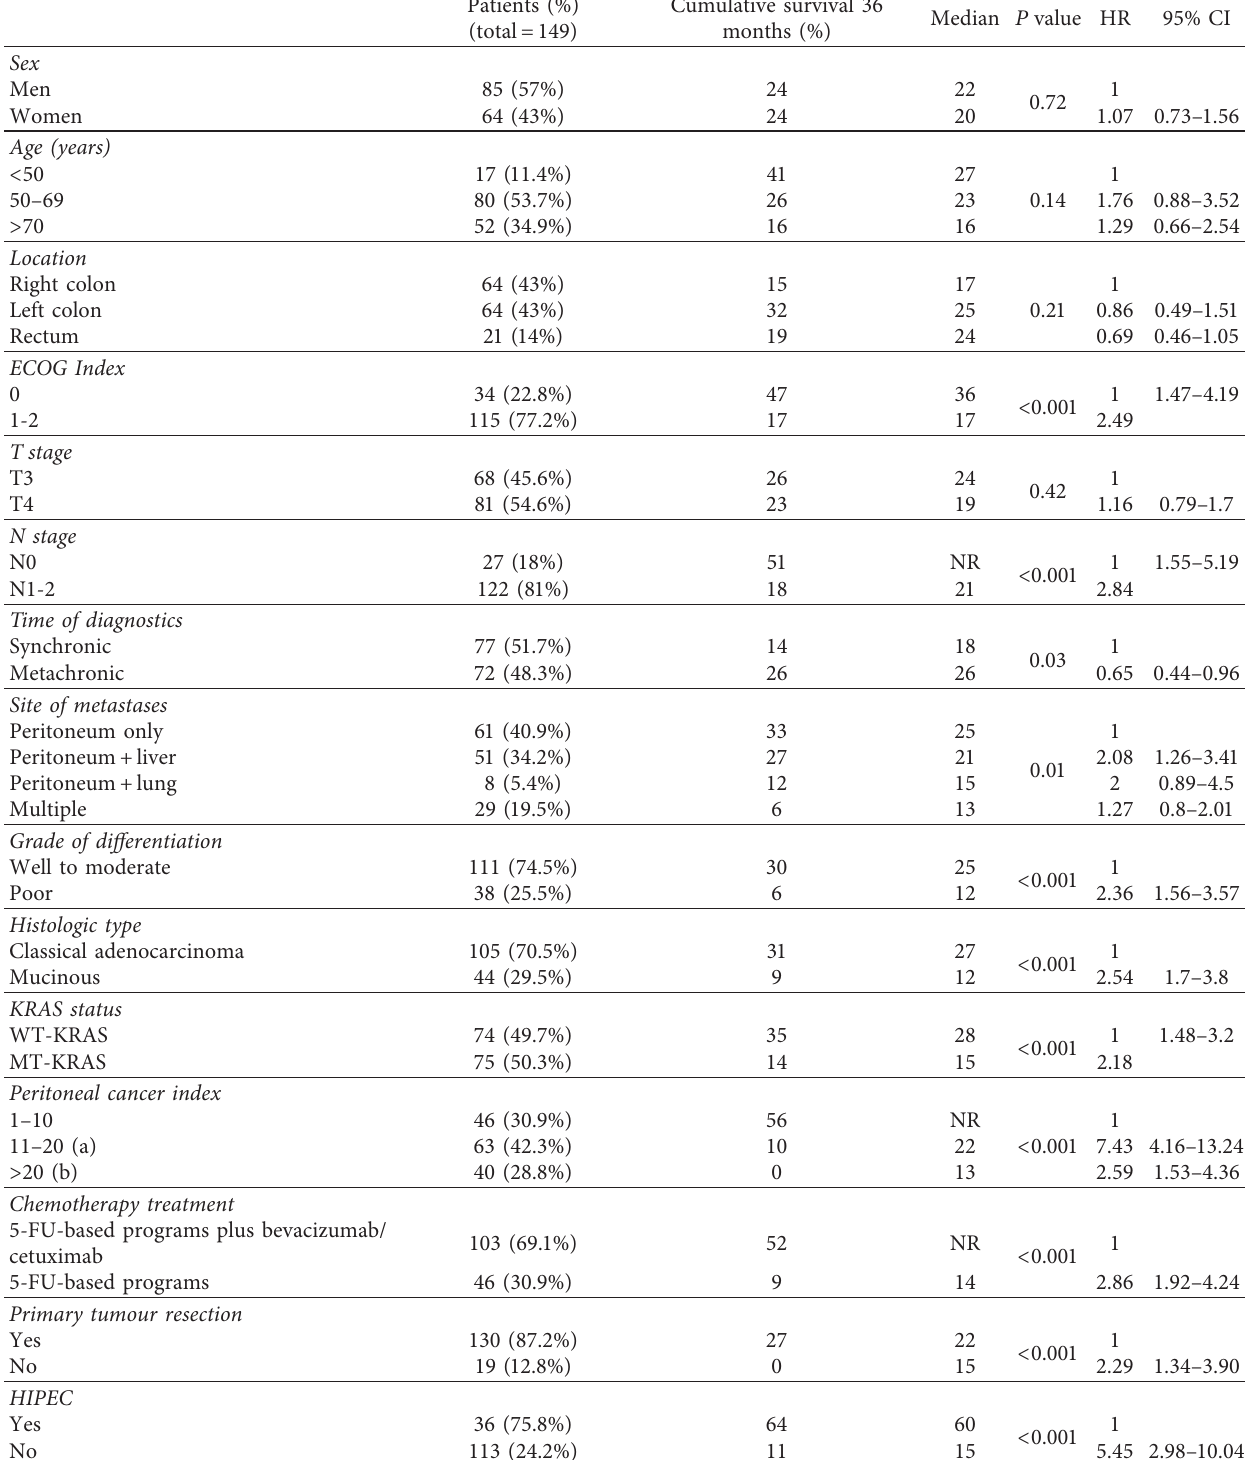
Table 1: Patient and tumour characteristics and survival estimate rates (95% CI) at 36 months after